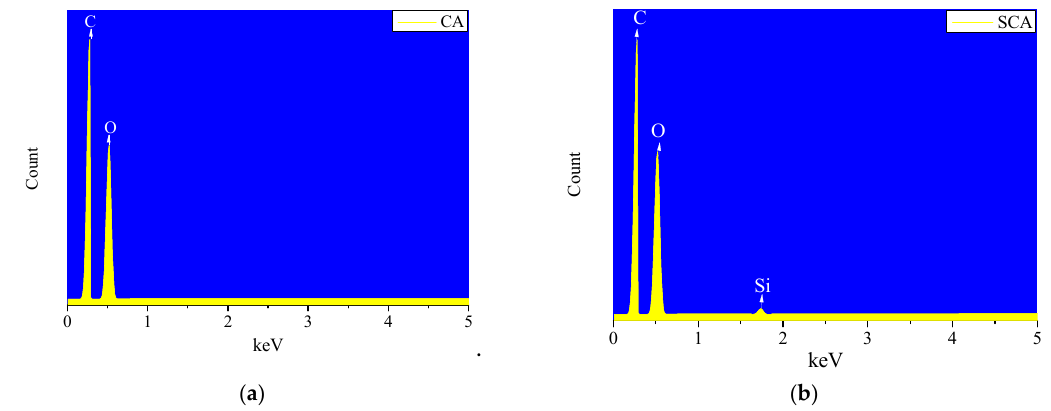
Figure 7. Energy dispersive X-ray spectroscopy (EDX) spectrum of ( a ) cellulose aerogel (CA) and ( b ) cellulose aerogel silanization with MEMO silane (SCA).